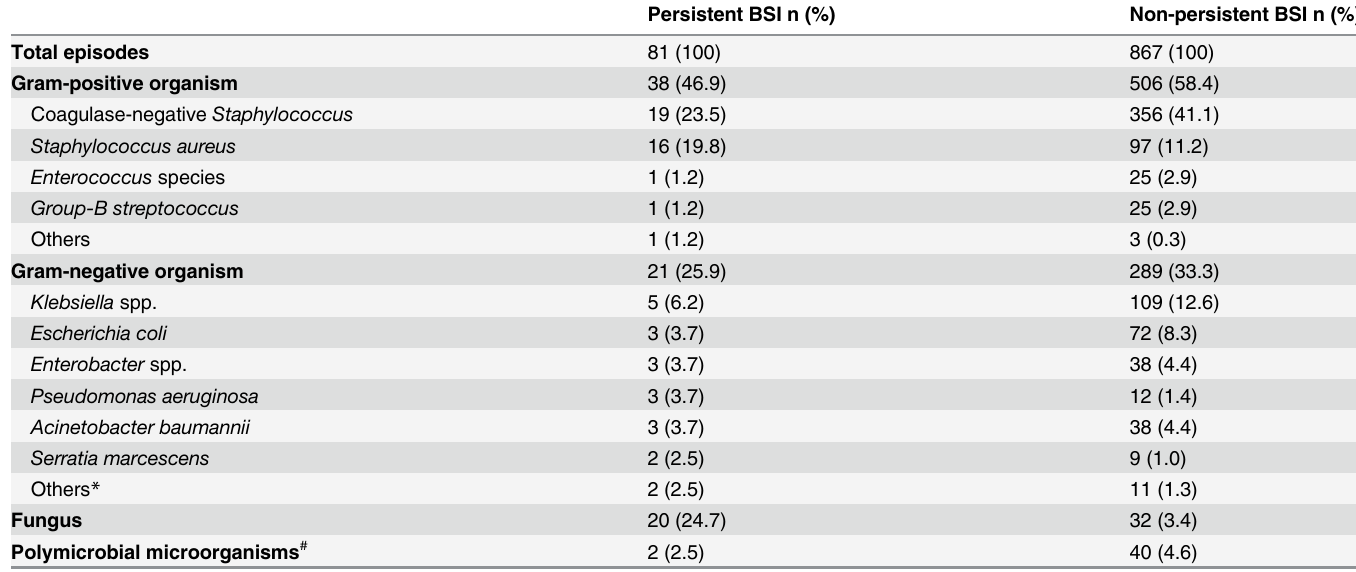
Table 1. Comparison of distribution of bacterial pathogens between persistent and non-persistent bloodstream infection (BSI) in infants hospital- ized in the neonatal intensive care